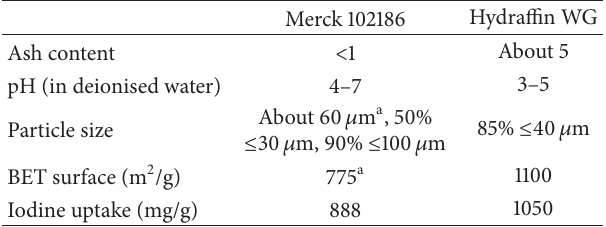
Table 1: Providers’ information about properties of the investigated activated